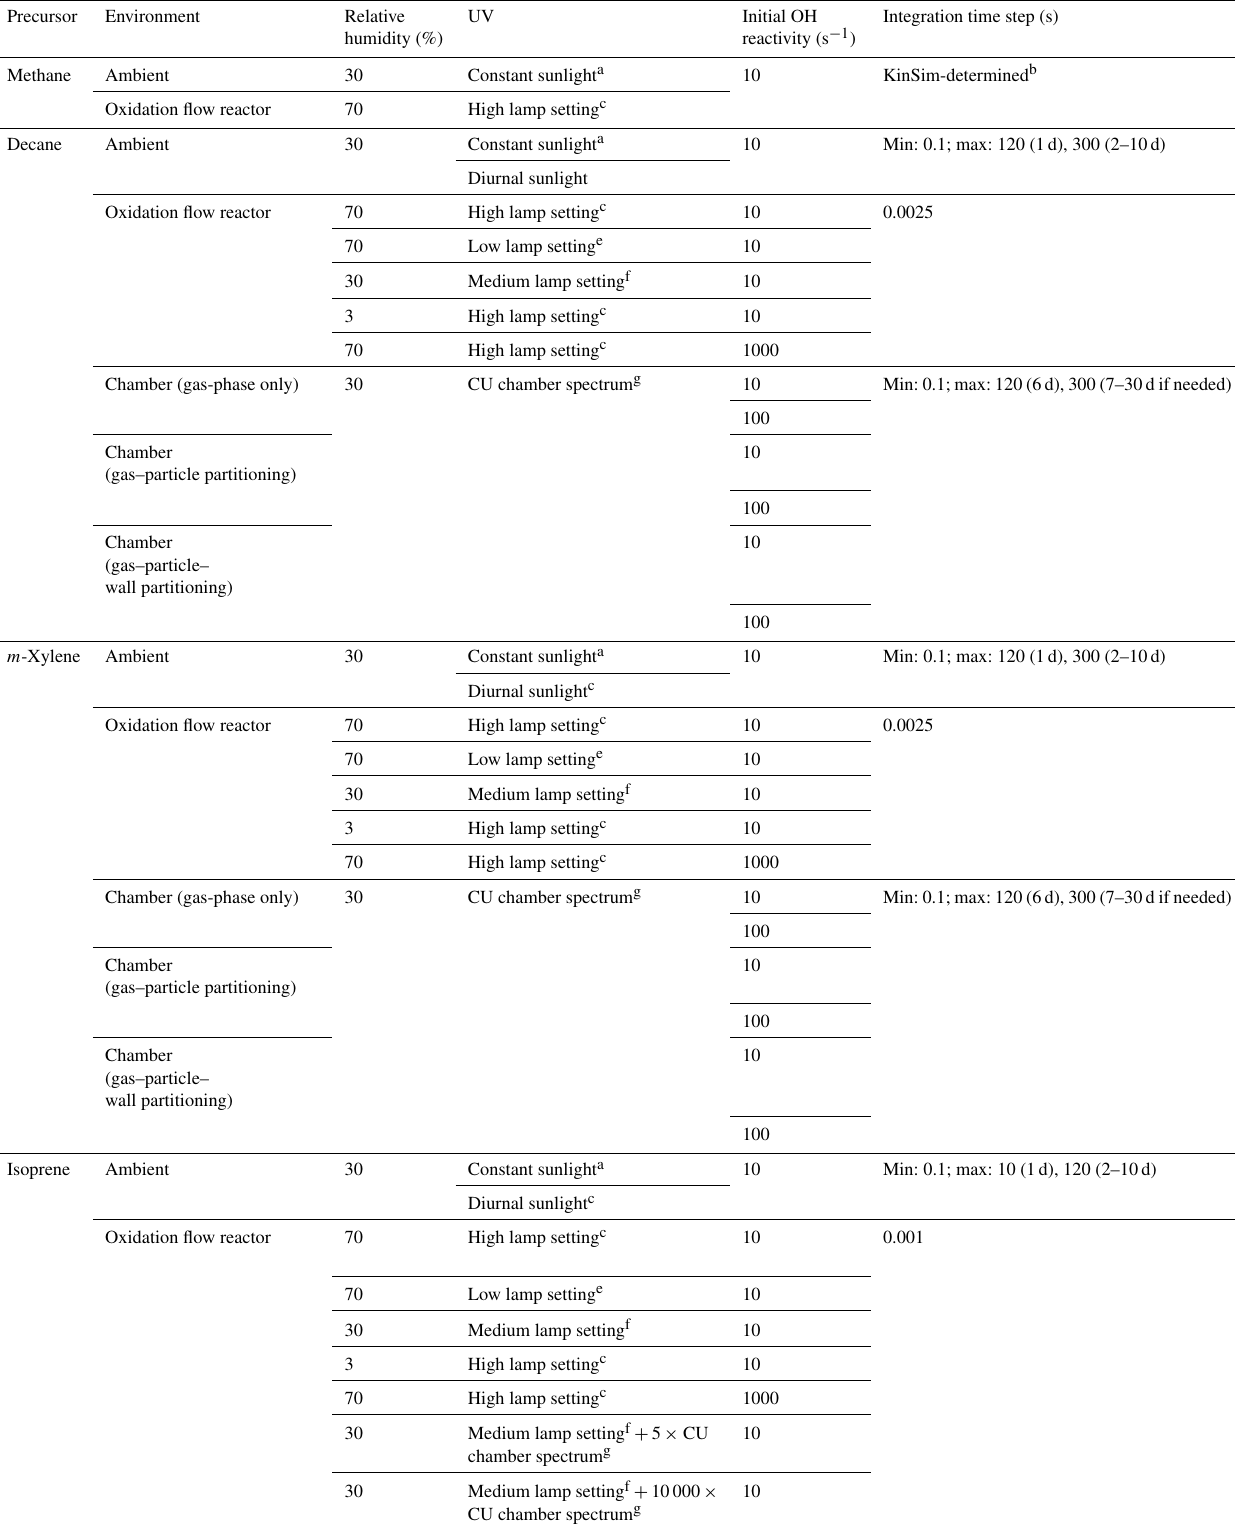
Table 1. Conditions and integration time steps of the simulations in the present work.